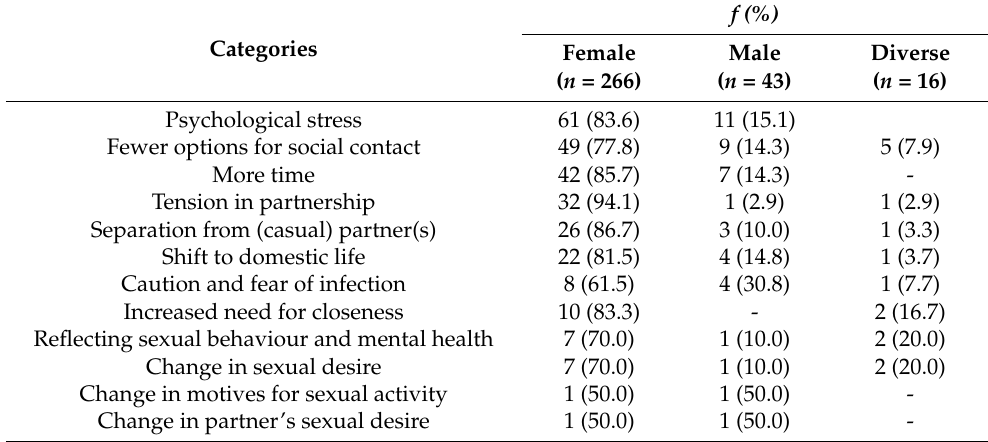
Table 6. Categories of reasons for changes in sexual behaviours, and respective frequencies by